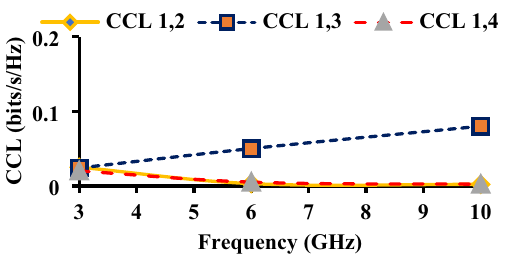
Figure 20. CCL of the proposed antenna.